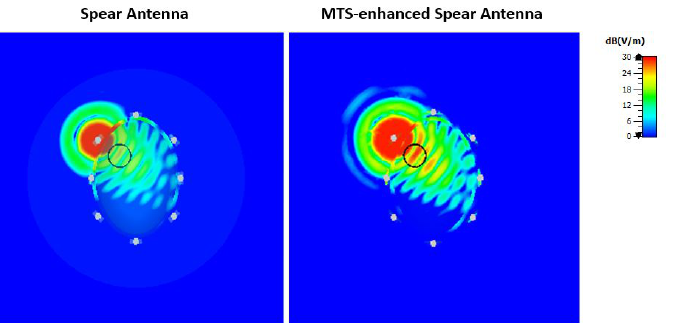
Figure 16. Real part of the E-field calculated at 1.55 GHz and plotted on a transverse section of the simulated brain phantom including a blood-mimicking target. A higher field intensity in the target region is shown when the MTS is placed adjacent on the spear antenna’s substrate (right plot). In particular, the E-Field values calculated at the centre of the target are 20.90 dB (V/m) and 24.90 dB (V/m) for the spear patch antenna and the MTS-enhanced spear patch antenna,